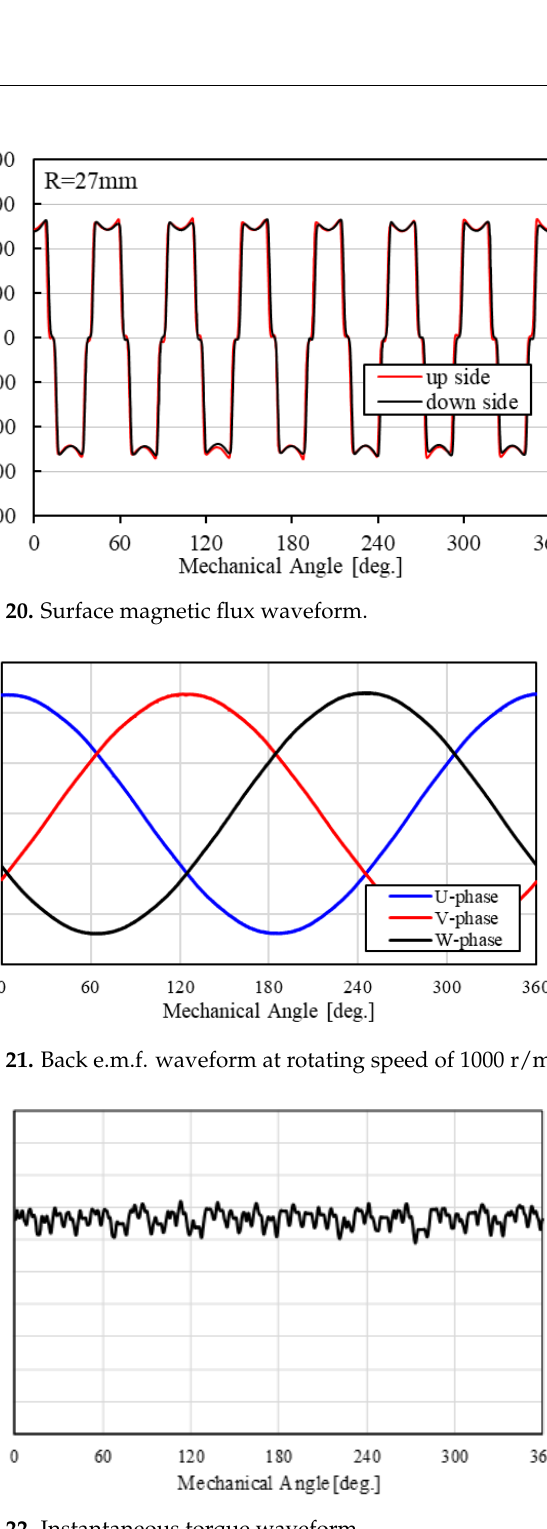
Figure 22. Instantaneous torque waveform.